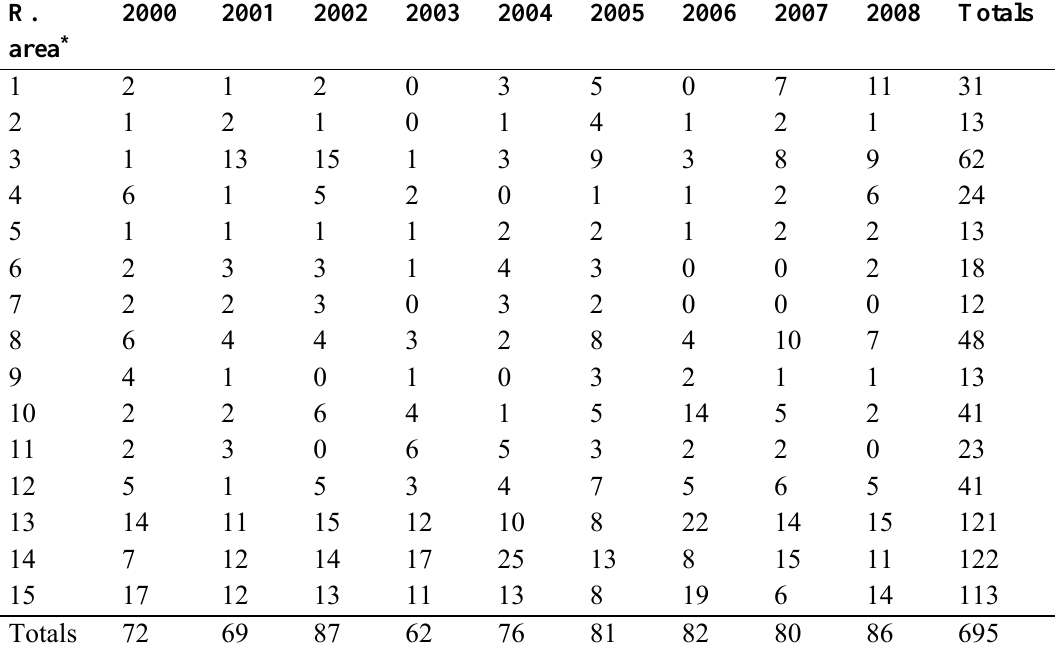
Table 4 Frequency of Articles by Research Area between 2000 and 2008 (N = 695)